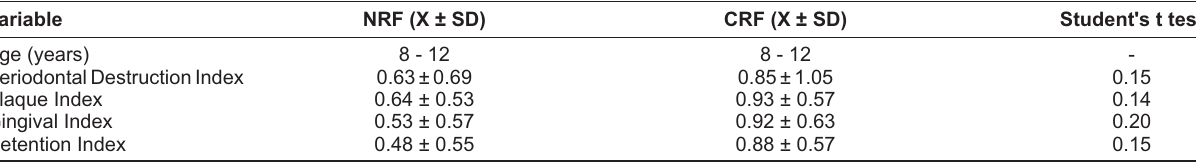
Table-2: Comparison of severity of periodontal disorders among dogs with renal dysfunction and dogs with normal renal function. Variable